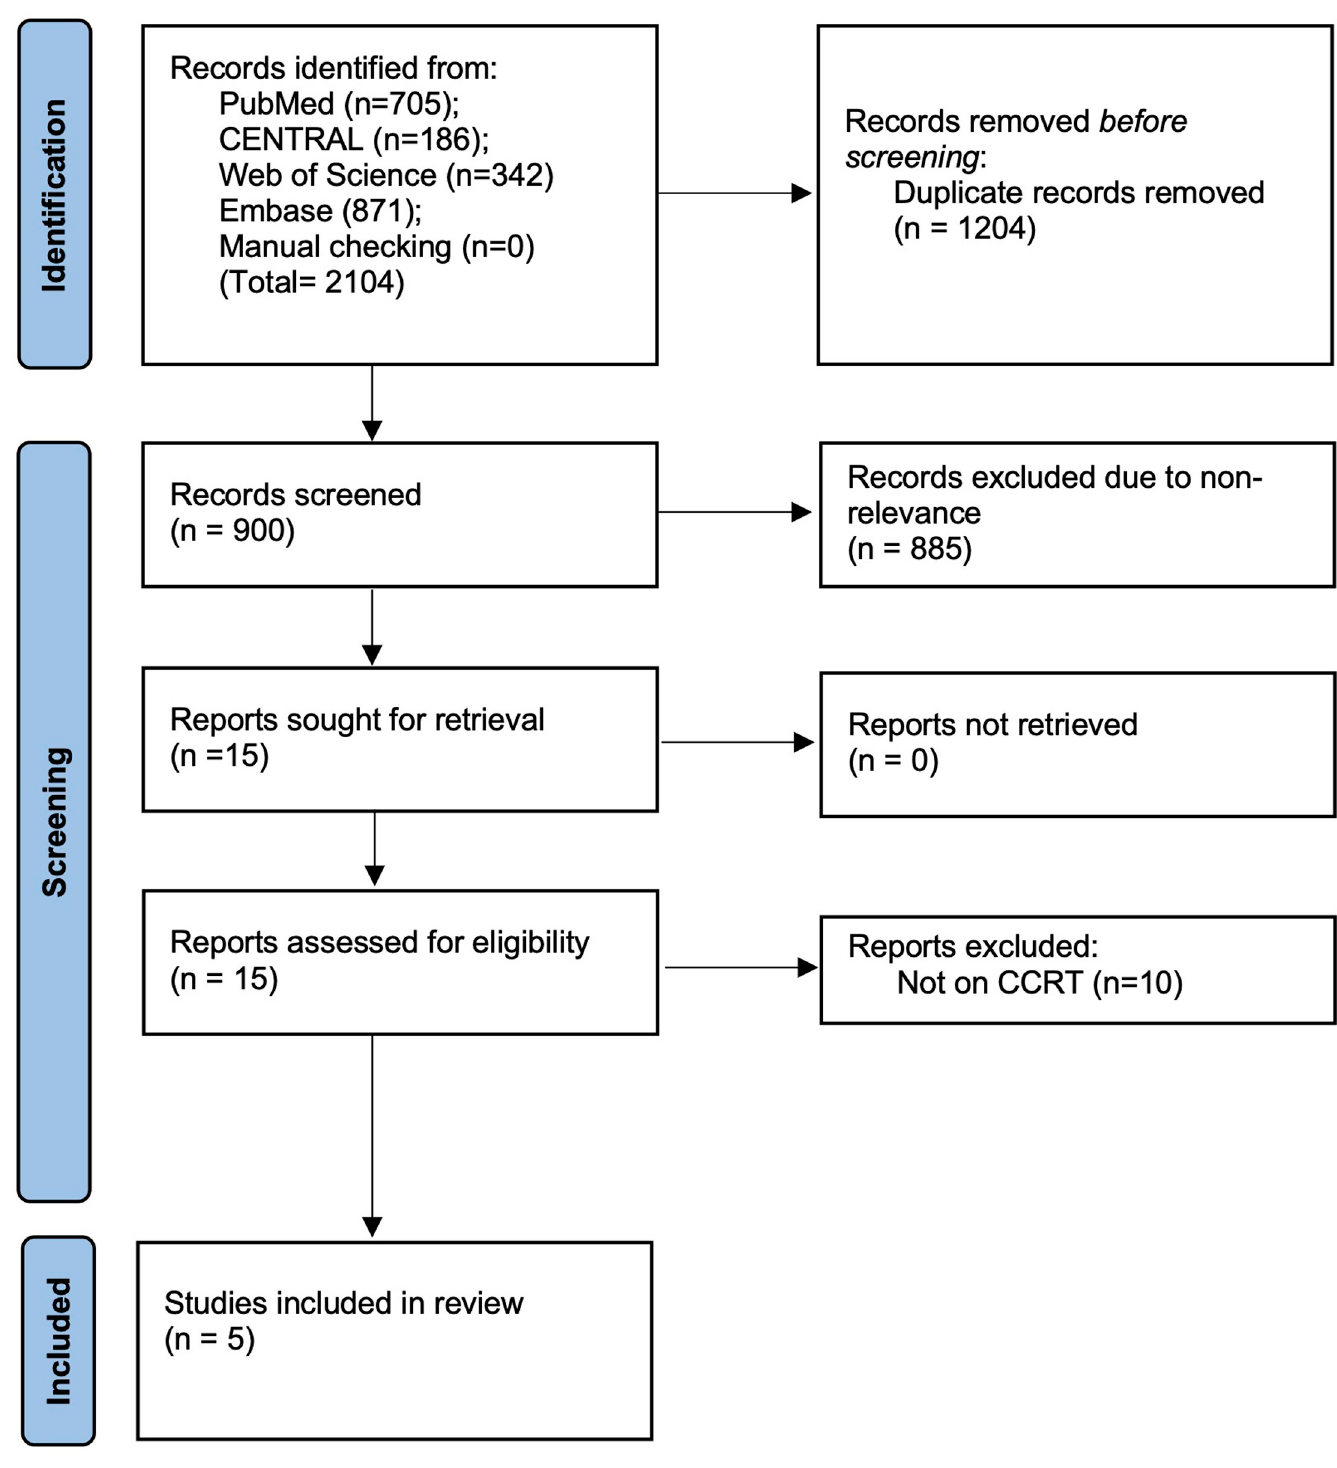
Fig 1. Study flow chart.